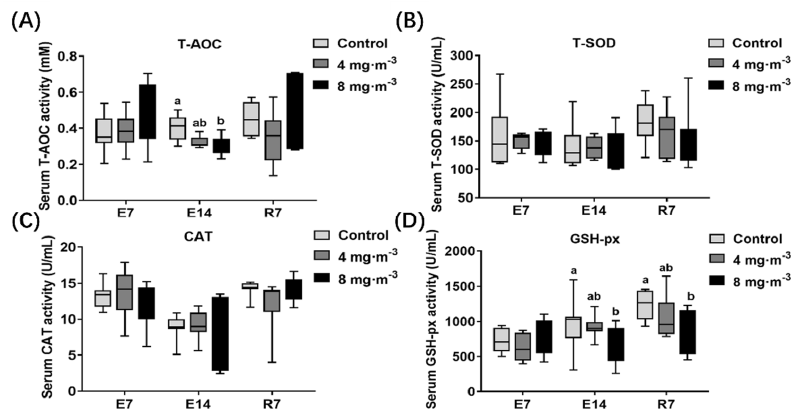
Figure 5. Effects of particulate matter exposure on the antioxidant enzyme content in serum of broilers. ( A – D ) represent the T-AOC, T-SOD, CAT, and GSH-px content in serum of broilers after E7, E14, and R7, respectively. Data are presented as mean ± SEM of groups (n = 8). Different letters indicate statistically significant differences between groups ( p < 0.05). E7, exposure for 7 days; E14, exposure for 14 days; R7, recovery for 7 days.